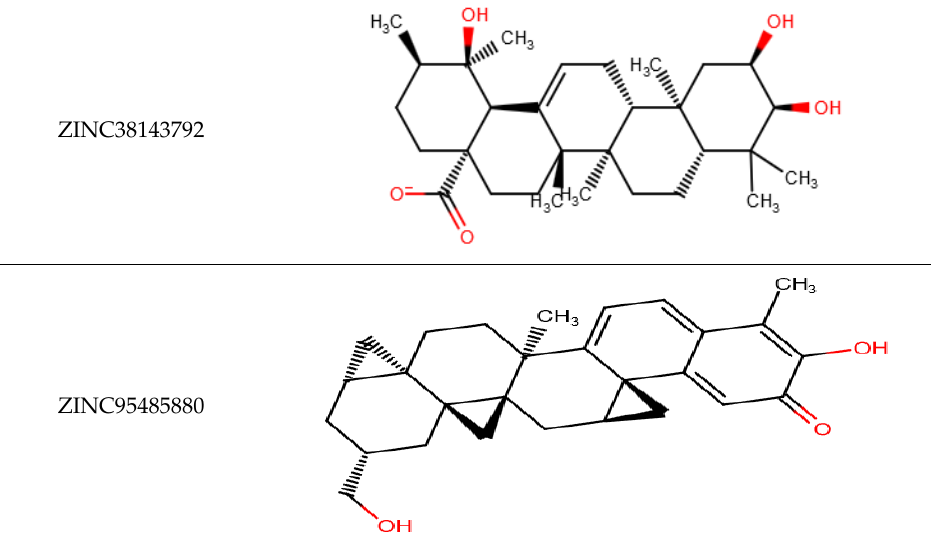
Table 6. A table showing the two-dimensional (2D) structures of three (3) selected leads generated with DrugBank